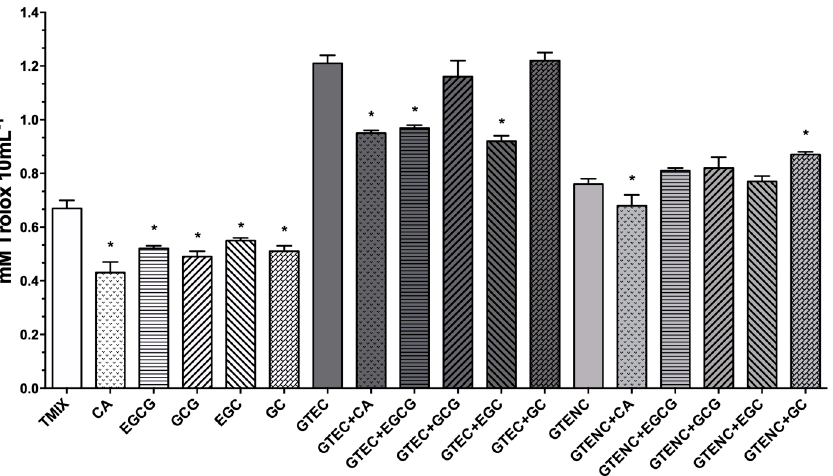
Figure 2. Antioxidant activity of green tea extract (GTE). Fresh (GTEC) and purified (GTENC) ex- tracts, where indicated, were doped with pure caffeine (CA), epigallocatechin gallate (EGCG), gallocatechin gallate (GCG), epigallocatechin (EGC), or gallocatechin (GC). The concentrations are outlined in Table 3 of the Experimental Design. Results are shown as means ± SD of mM Trolox 10 mL − 1 . * p < 0.05 between doped extracts and their corresponding non-doped extract or between the individual compounds and TMIX (Tukey’s multiple test). TMIX: Mixture of GTE’s major phenolic com- pounds.